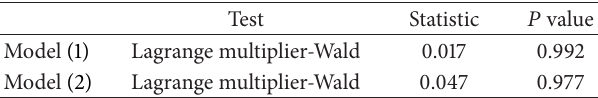
Table 5: Tests of no remaining nonlinearity (test for the number of regimes).